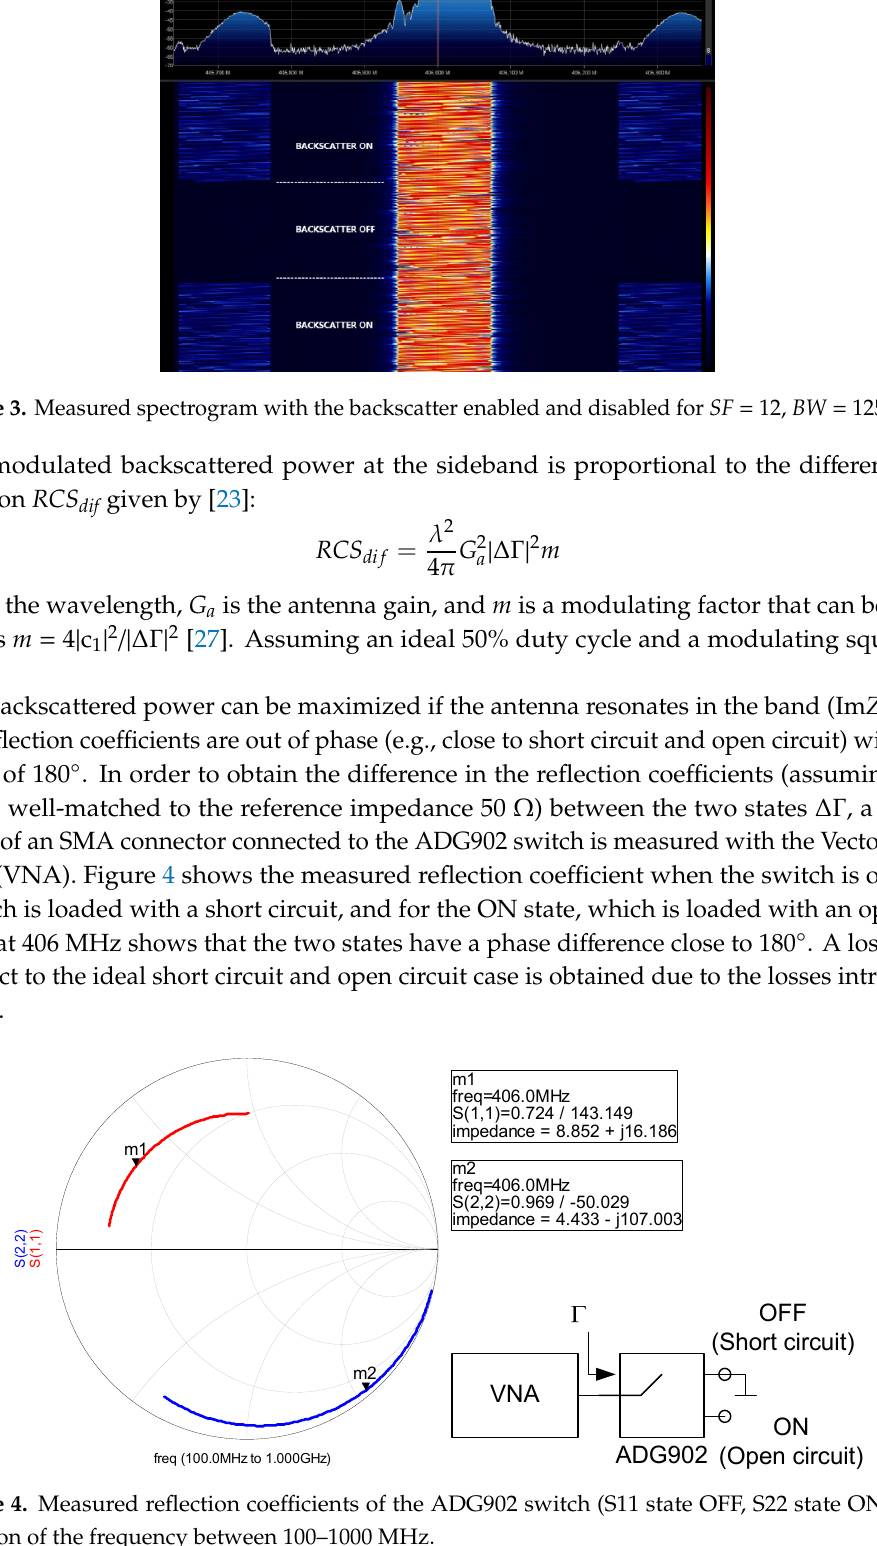
function of the frequency between 100–1000 MHz.